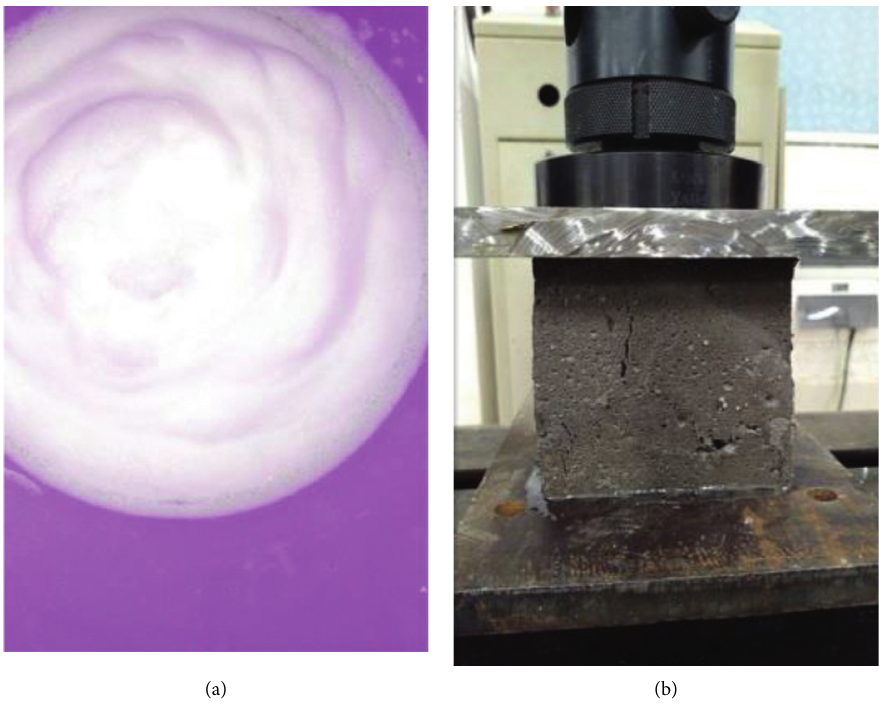
Figure 3: Uniaxial compression test of foam concrete.